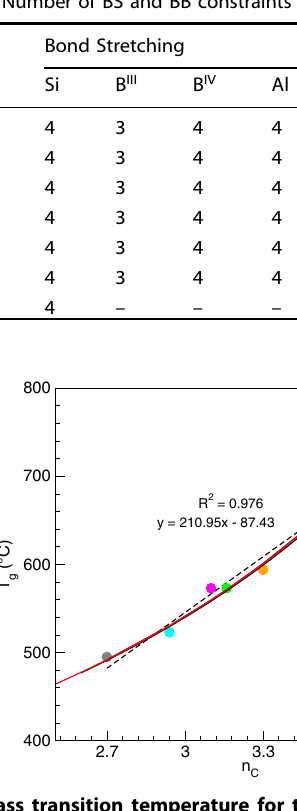
Fig. 9 Silicon-based ln ( r 0 ) for the seven simple glasses as a function of the number of constraint per atom n c , averaged on all elements. Inset displays the evolution of silicon-based ln ( r 0 ) as a function of NBOs. Colors attributed to each point corresponds to each glass as used in Fig.